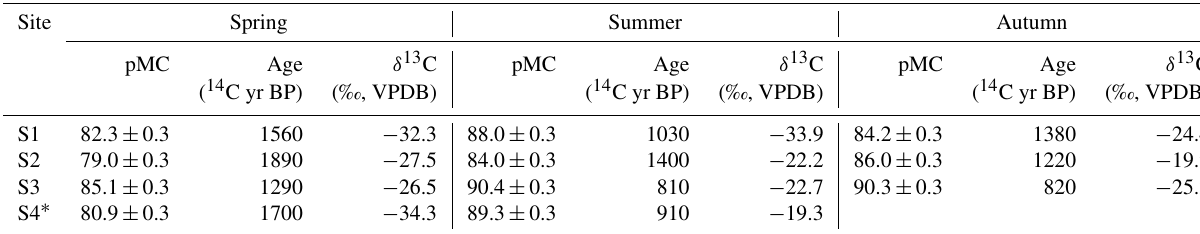
Table 2. Carbon isotope signature of the emitted CO 2 from the Wuding River catchment ( ± 1SD).